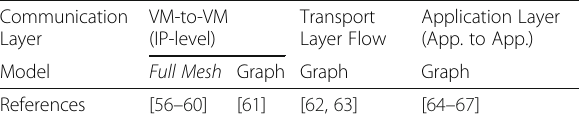
Table 10 List of Assumptions and alternative possibilities: